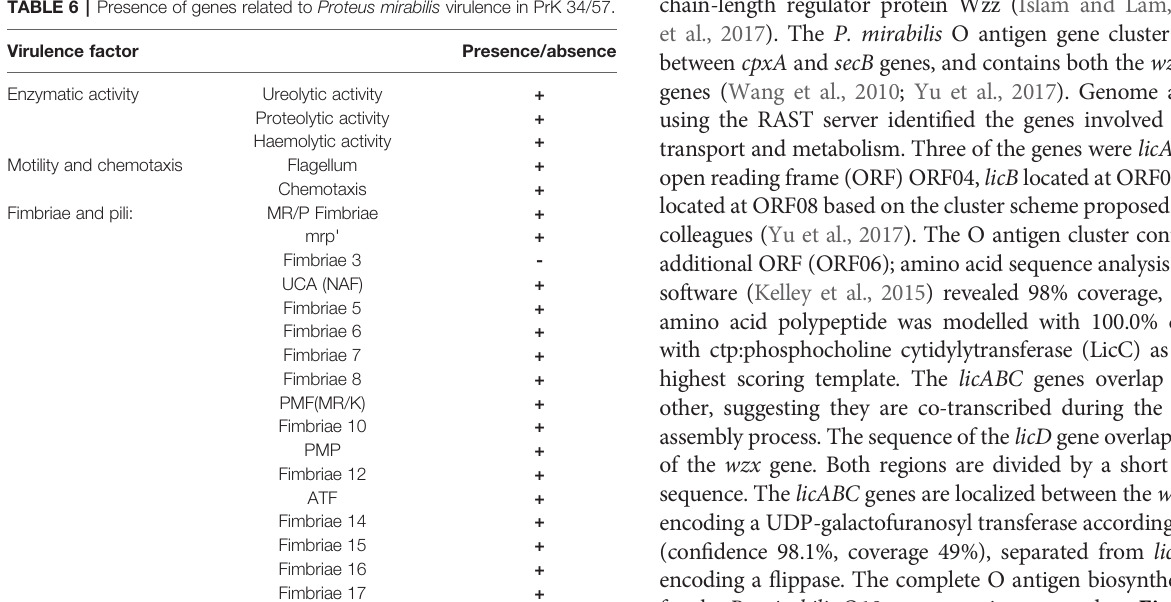
TABLE 6 | Presence of genes related to Proteus mirabilis virulence in PrK